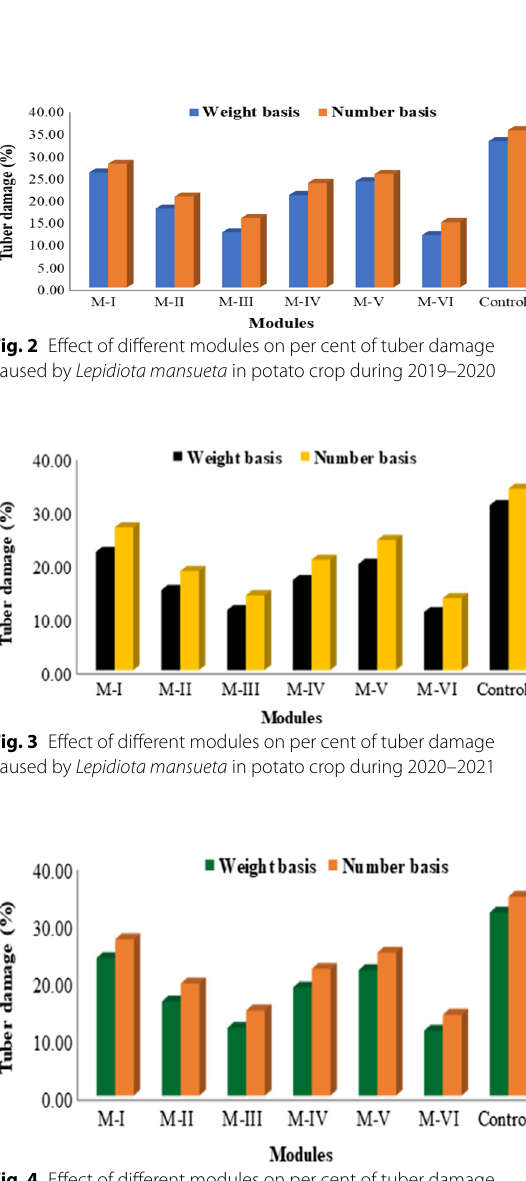
Fig. 4 Effect of different modules on per cent of tuber damage caused by Lepidiota mansueta in potato crop (pooled